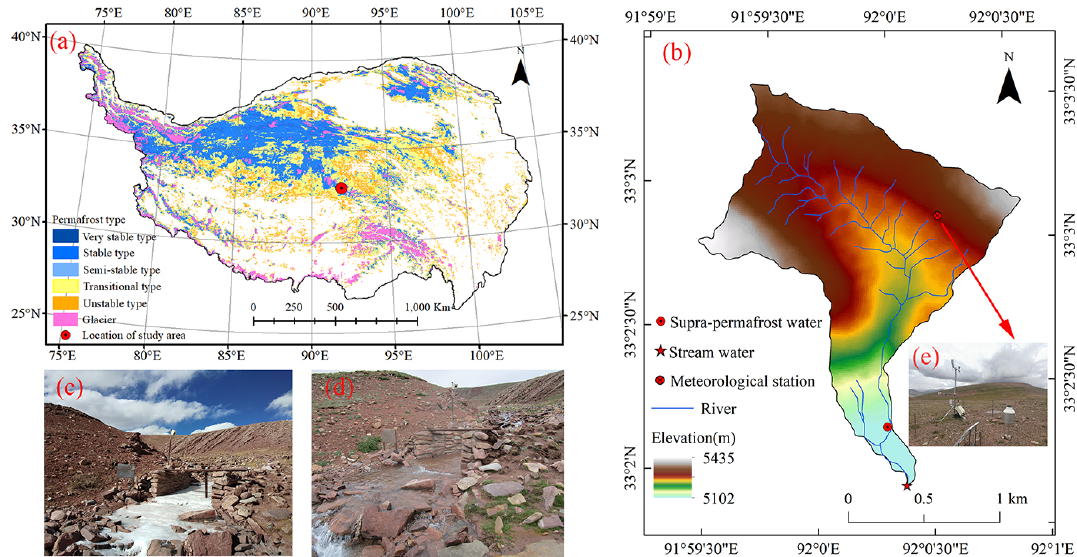
Figure 1. (a) Map of permafrost thermal stability on the Tibetan Plateau; (b) map of the study area and the sampling sites; (c–d) images of the frozen river in this catchment during the cold season and the runoff generated during the warm season. (e) Photograph of the underlying surface of the catchment and meteorological station. Thermal stability of permafrost distribution data are from the National Tibetan Plateau Data Center (TPDC) (http://data.tpdc.ac.cn/, last access: 13 September 2021) published by Ran et al. (2020). Digital elevation model (DEM) data available from Geospatial Data Cloud (http://www.gscloud.cn/, last access: 25 August